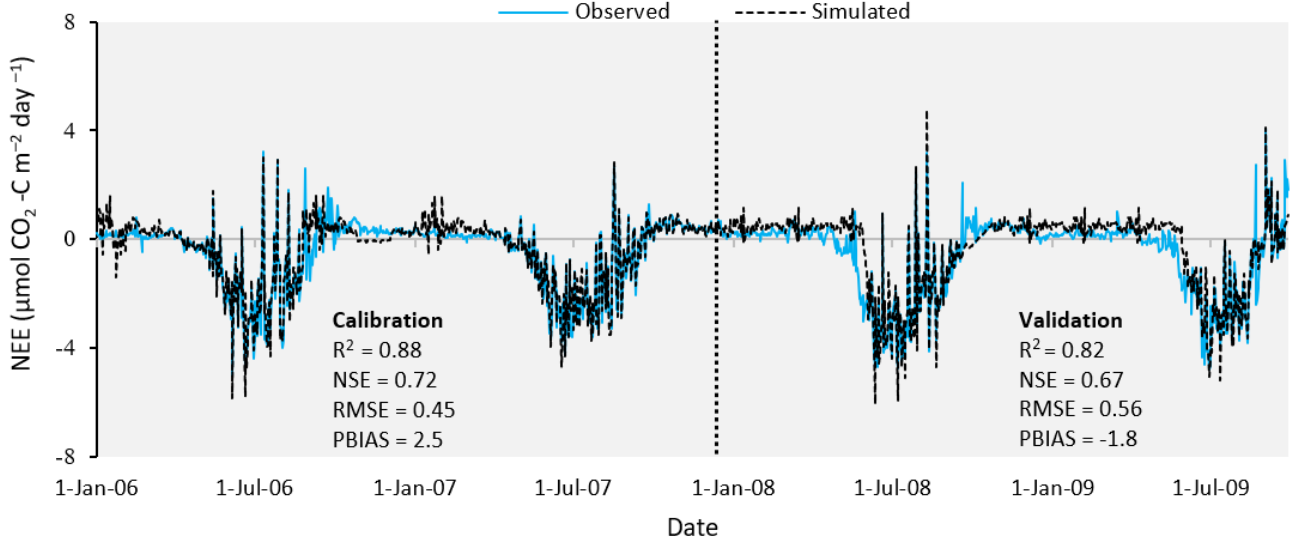
Figure 5. NEE calibration and validation results at Athabasca River Basin.